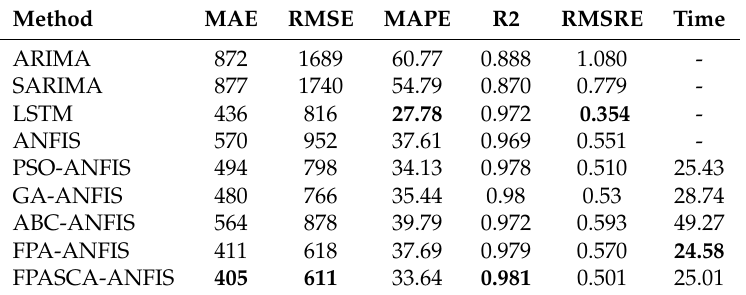
Table 1. Computational results of USA.